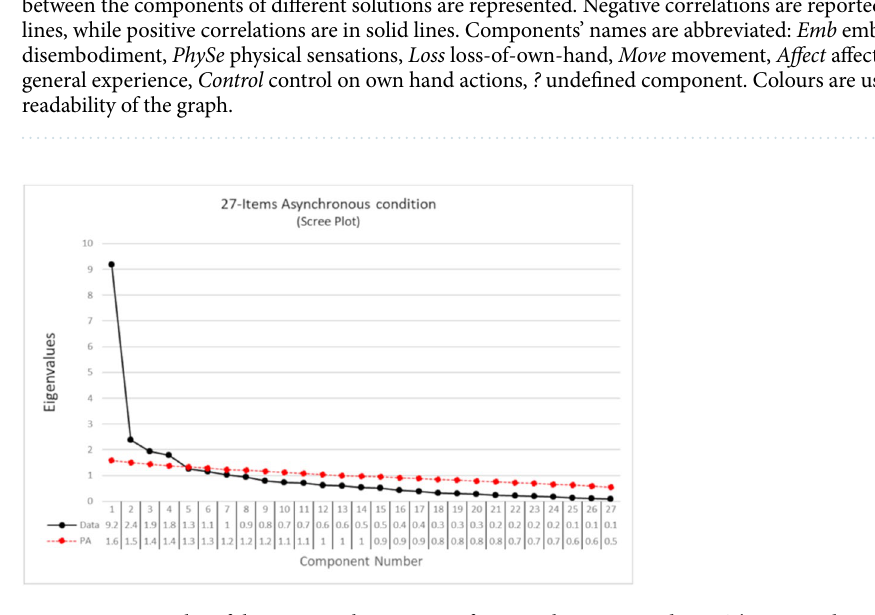
Figure 3. Scree-plot of the PCA on the 27 items after asynchronous condition. The eigenvalues are reported in the table below the graph. The black dots represent the eigenvalues of each component in decreasing order. The red line shows the simulated data of the parallel